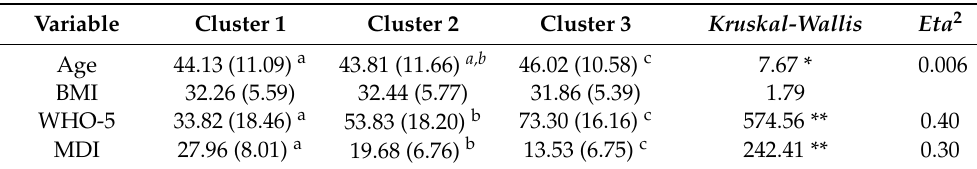
Table 5. Mean comparisons on the well-being, depression and sociodemographic data in the female subsample.